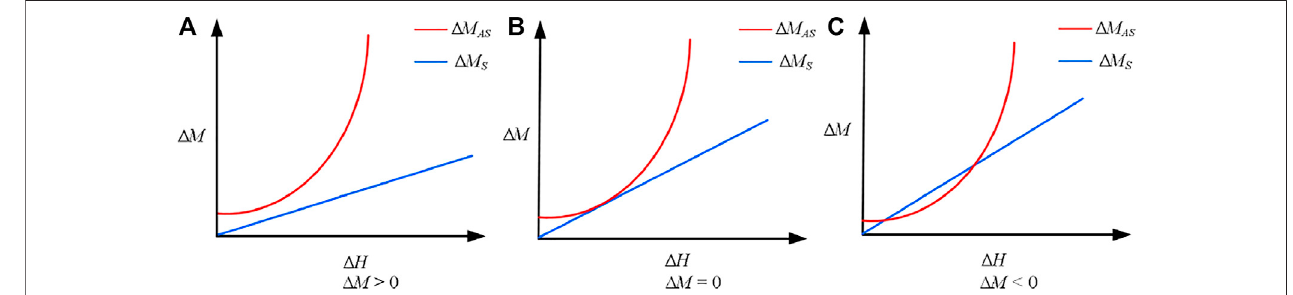
FIGURE 5 | Relationship curves of Δ M and Δ H . (A) Δ M > 0, (B) Δ M = 0, (C) Δ M <